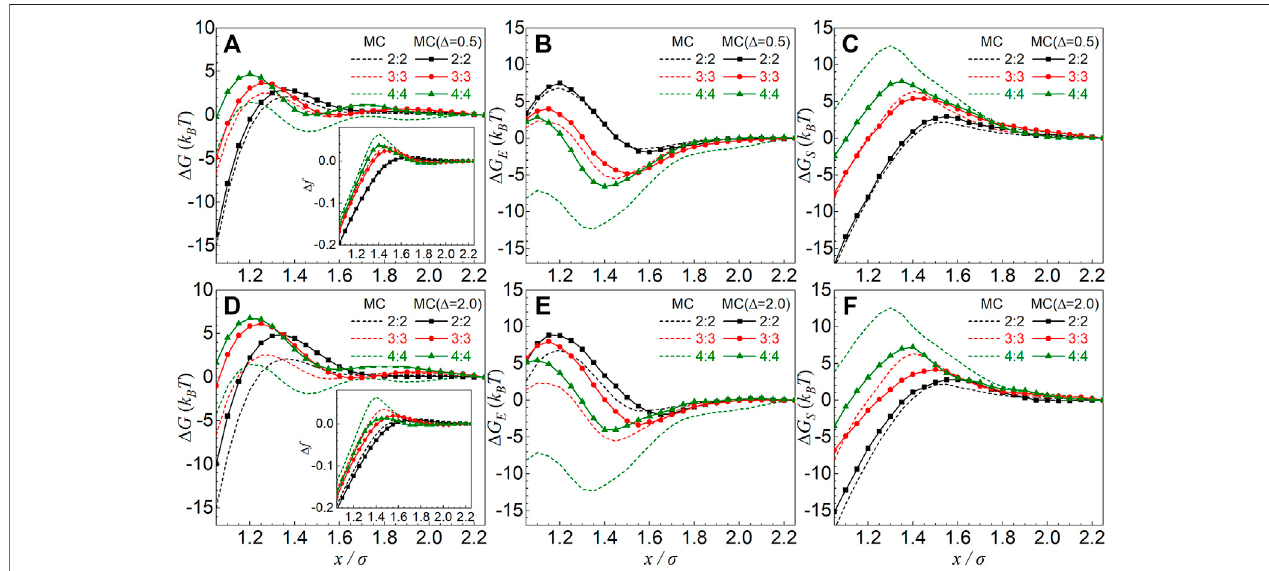
FIGURE 7 | (A, D) Effective potentials of mean force Δ G(x) between equally and oppositely charged particles with |Z| (cid:1) 36 e at 0.3 M symmetrical 2:2, 3:3, and 4:4 salts, from the MC simulations with involving local-ranged counterion – co-ion repulsions of Δ (cid:1) 0.5 Å (A) and Δ (cid:1) 2 Å (D) (see Eq. 5 ). The insets are the relative charge fraction Δ f (cid:1) f(x) − f(x ref )ofcondensed counterionsasafunctionofseparationxbetweentwoparticles. Thedashed linesarethesameasthelinesin Figures2C,F , 5C,F . (B, C) Electrostatic energy Δ G E (x) (B) and entropic free-energy Δ G S (x) (C) as functions of separation x, which are split from Δ G(x) in panel A. (E, F) Electrostatic energy Δ G E (x) (E) and entropic free-energy Δ G S (x) (F) as functions of separation x, which are split from Δ G(x) in panel D. The reference separation was taken as